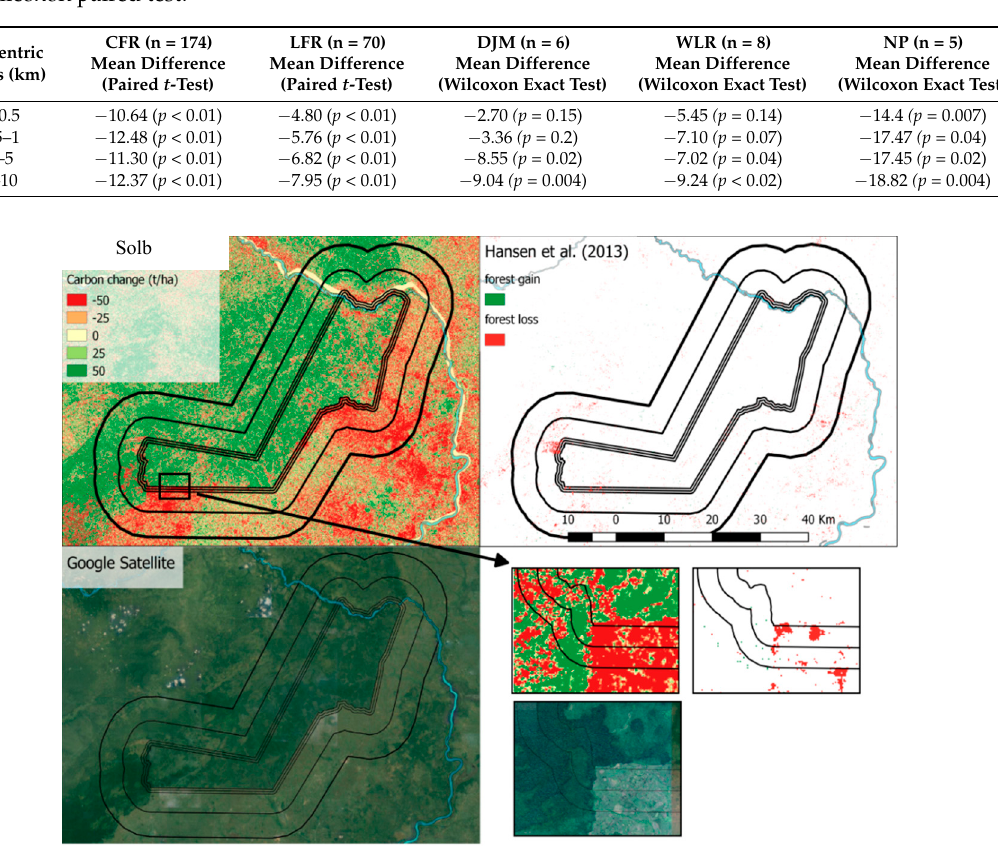
Figure 7. Carbon change in ineffective PA, Mabira Central Forest Reserve, and carbon losses (red) inside PA boundary and the external buffer zones. Other figures are, for visual comparison, extracts of Google Earth images and Global Forest Watch forest cover change for the same period (2000–2012) [34].